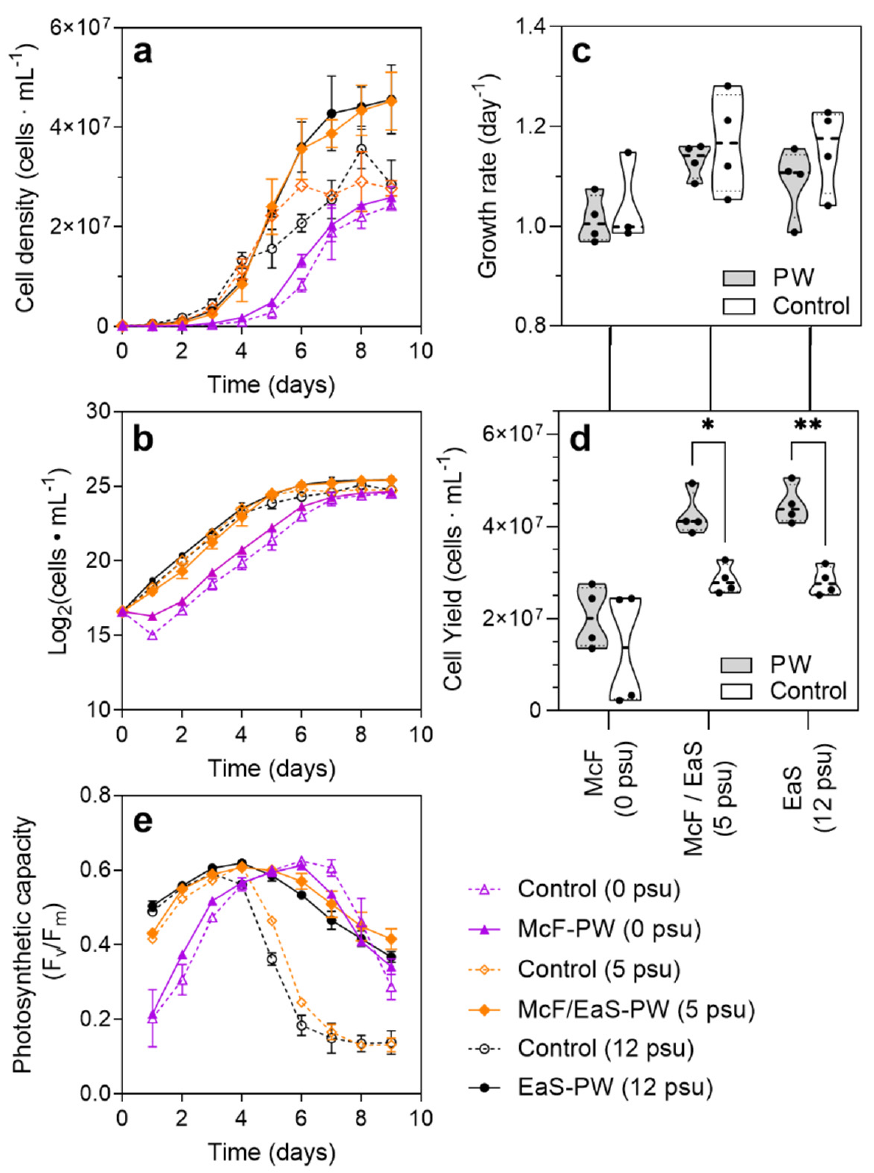
Figure 2. Growth characterization of Pt1 cultures in EaS-PW, McF-PW, and EaS/McF-PW medium. Growth curve based on cell density counts ( a ) and log 2 -transformed cell density counts ( b ). Truncated violin plots showing the frequency distributions of the growth rates ( c ) and cell yields ( d ). Individual data points are shown as dots, the median is represented by a dashed line, and quartiles are represented by dotted lines. The starred comparison marks indicate significant differences in the dependent variable (*: adj. p < 0.05; **: adj. p < 0.005) based on two-way ANOVA post hoc multiple comparisons between the PW treatments and their controls ( n = 4). One outlying growth rate value was removed from the 0 psu control condition (see Supplemental File S1). ( e ) Photosynthetic capacities (F v /F m ) of cultures in ( a , b ). For graphing clarity, panels ( a , b , e ) show data from the second trial only ( n = 2); Error bars represent standard deviations around the mean. The first trial showed comparable growth dynamics and its results are available in Supplementary File S1.